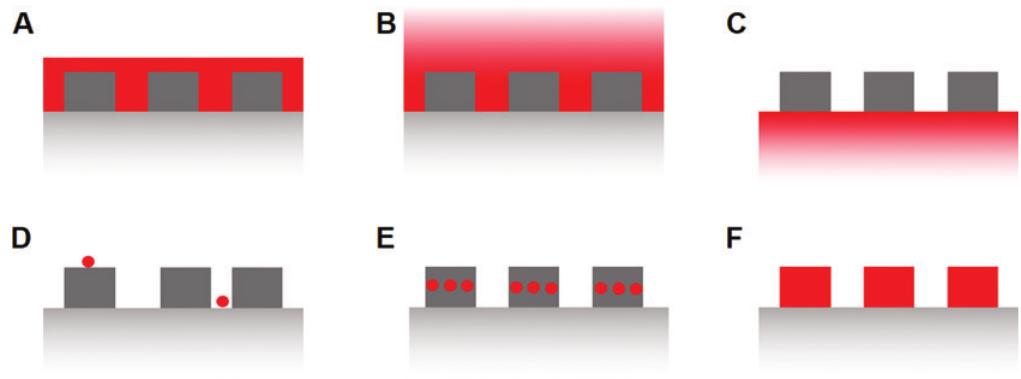
Figure 13: Schematic illustration of different possibilities to integrate emitters with metasurfaces. (A) Covering of the metasurface with a light-emitting thin-film. (B) Immersing the metasurface into a liquid containing fluorophores. (C) Placing the meta-atoms on a fluorescent substrate. (D) Precise placement of nanoemitters at specific positions on or next to the meta- atoms. (E) Fabrication of the metasurfaces from high-refractive-index materials incorporating nanoscale emitters. (F) Fabrication of the metasurfaces from luminescent